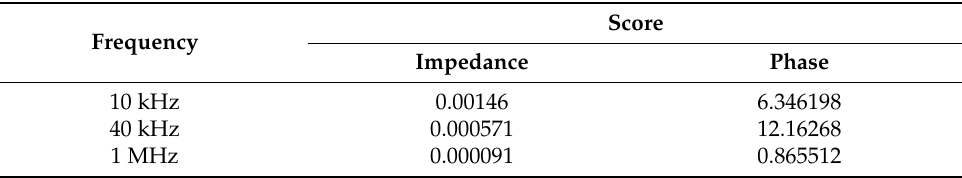
Table 1. Features Score Calculated using χ 2 Test (Higher the score is more contribution of a feature during